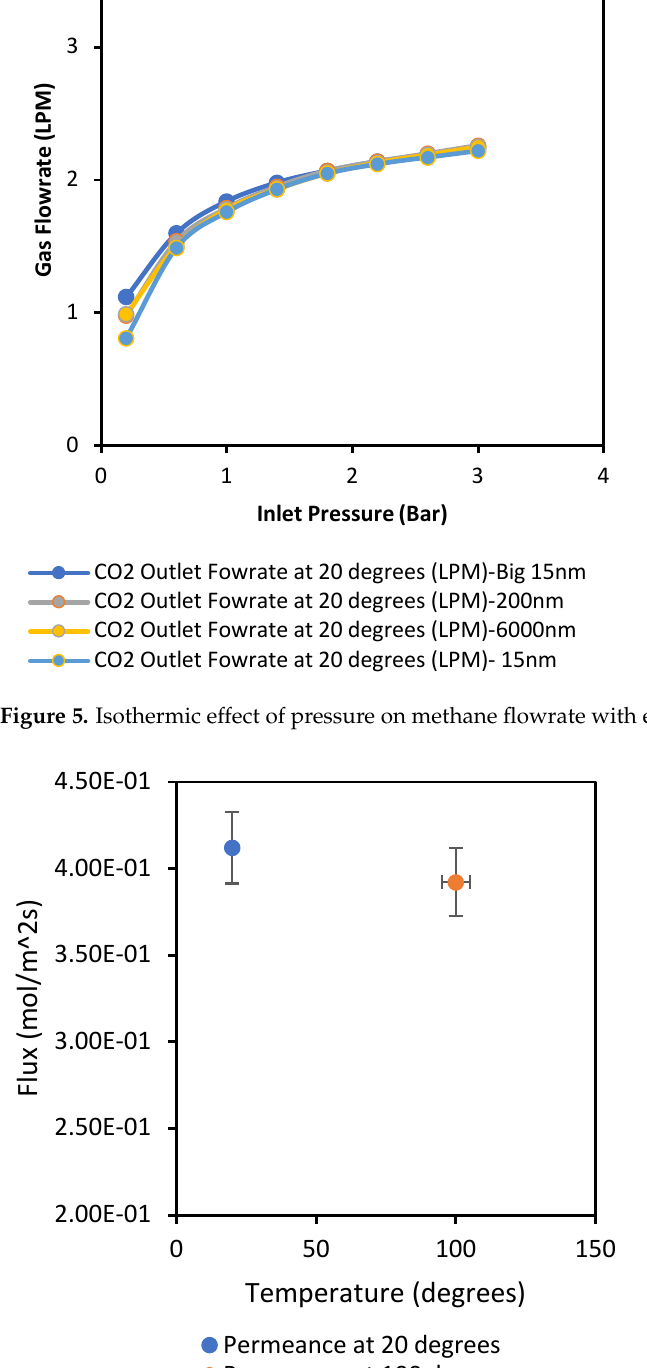
Figure 7. Effect of temperature on flux for CO 2 gas through 15 nm membrane at 1 bar. 5. Conclusions This study confirms that both fluid and structural properties play a vital role in determining the performance of methane and carbon dioxide gas separation with inorganic ceramic membranes. The results show that a combination of flow mechanisms is at play in gas transport through membranes owing to the inherent properties of the membrane. In this case, viscous and Knudsen flow occur in parallel due to the presence of defects in the pore structure which impact the mode of gas transport through the pores. The study also shows that depending on the properties of the gases, microporous membranes are sufficient to initiate a degree of selectivity sufficient for Knudsen separation. Further study is being carried out to investigate the effect of loading the membrane support with high affinity material that will not only improve adsorption properties but will also reduce pore size, and ultimately, improve the selectivity of the membrane. The effect of subsequent loadings on permeance and selectivity will be studied and compared with what was achieved from these initial support characteristics. This will provide more information on optimising membrane performance to enhance the mass